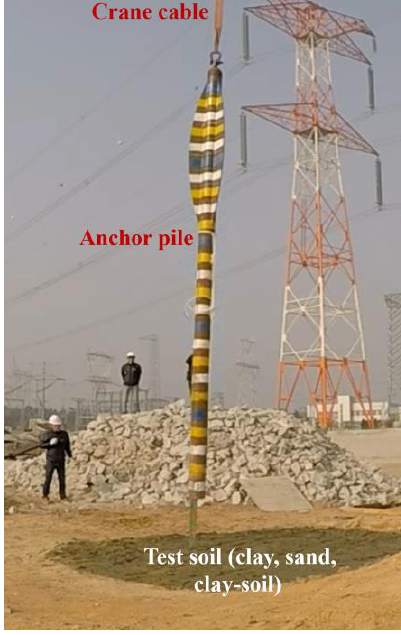
Figure 11. Field verification test configuration for soil penetration of anchor pile.